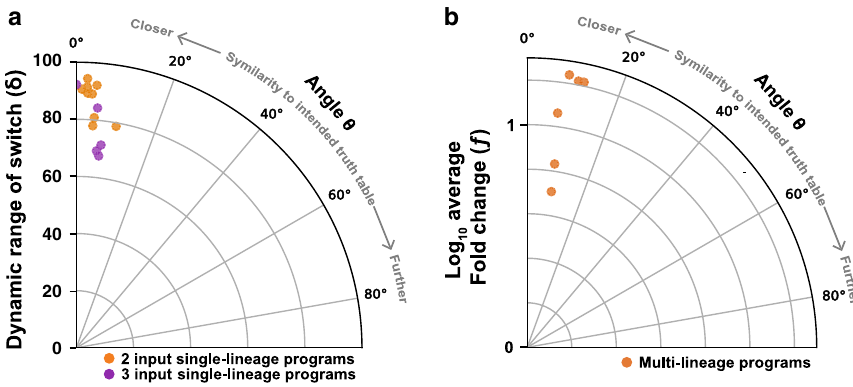
Fig. 7 Robustness of history-dependent programs. Angles representing the similarity between biological and the ideal implementation of history- dependent programs were plotted. The lower the angle deviation is from 0°, the closer the program behavior is to its expected one. a Switching robustness, with angles computed from percentage of cell versus the worst-case switching rate of the switch ( δ ), were plotted. b Implemented multicellular programs robustness with angles evaluated between biological and expected fl uorescence from plate reader measurement versus the logarithm of average fl uorescence fold change ( f )